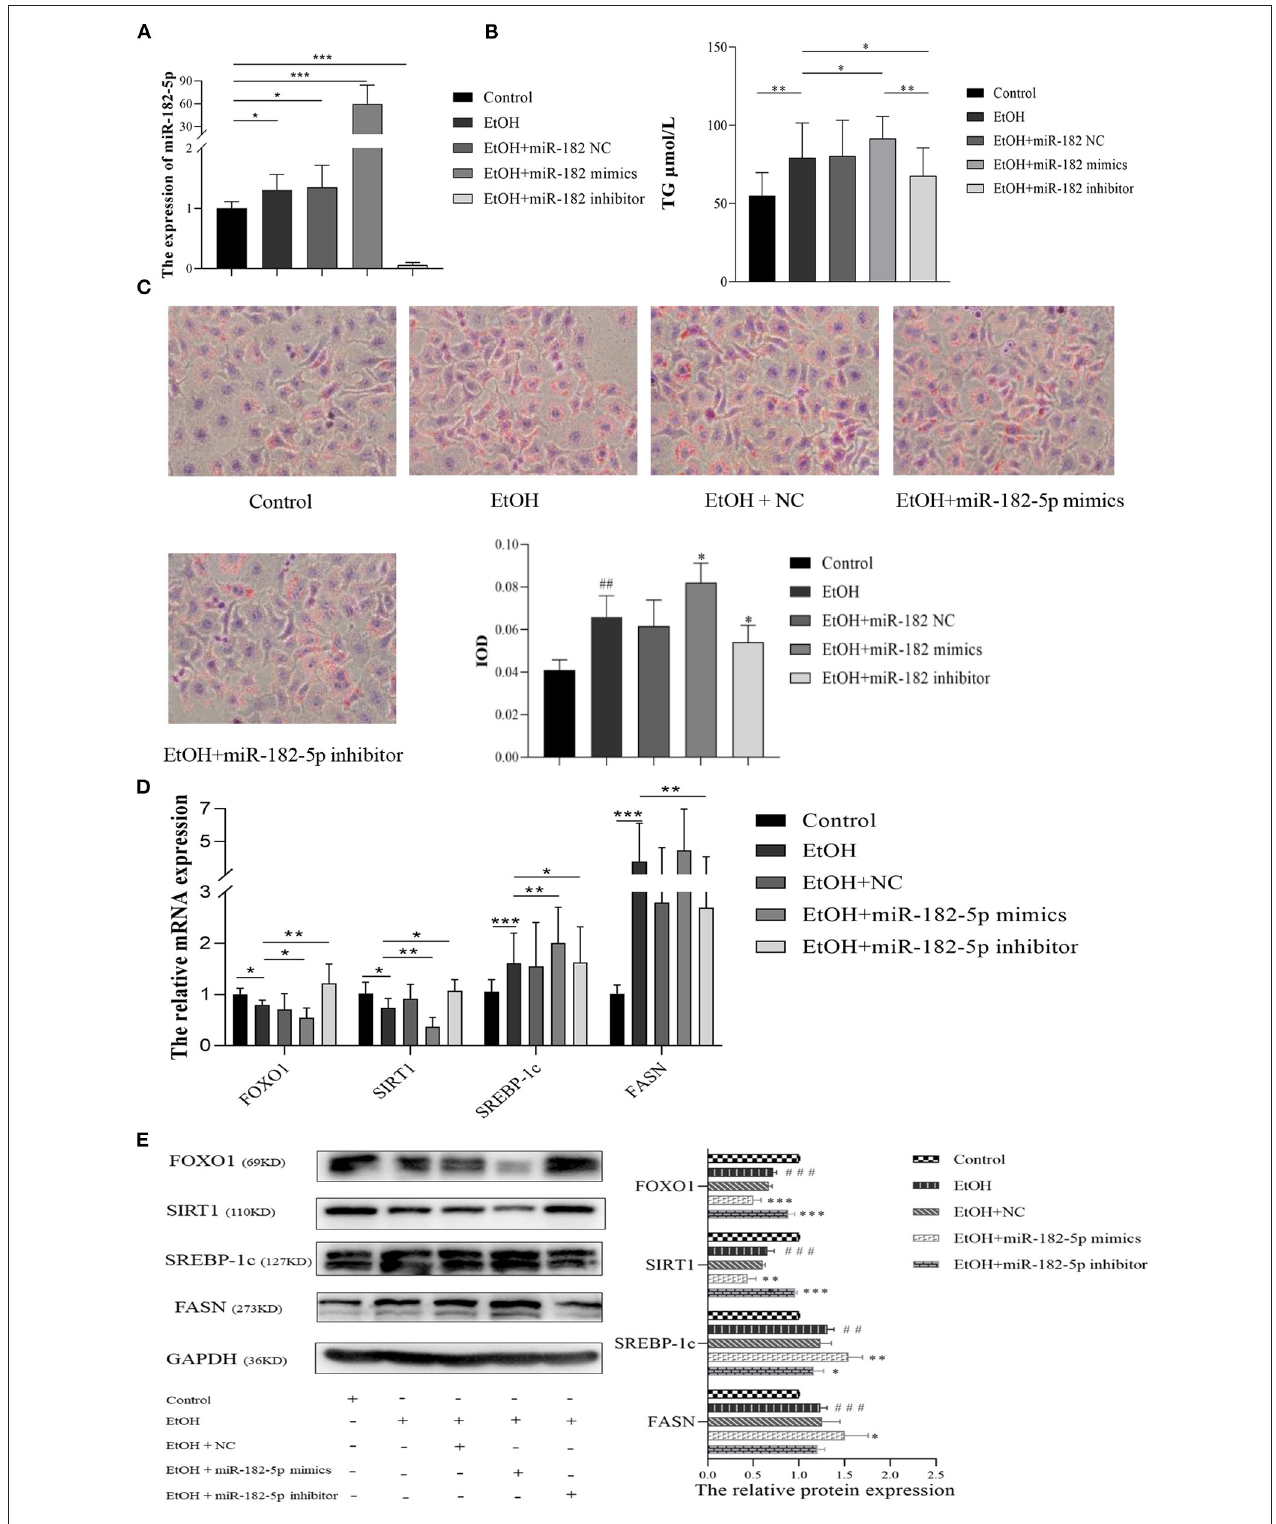
FIGURE 8 | The molecular mechanism of miR-182-5p in ALD lipid accumulation. (A) Verification of miR-182-5p expression, (B) TG levels of ALD cells with miR-182-5p mimics, NC, and inhibitor transfection, (C) Oil Red O staining and IOD analysis, (D) mRNA expression levels of FOXO1 downstream genes, (E) western analysis of FOXO1, SIRT1, SREBP-1, and FASN protein expression after transfection. TG, triglycerides; NC, negative control; IOD, integrated optical density. ## p < 0.01, ### p < 0.001 vs. control group; * p < 0.05, ** p < 0.01, *** p < 0.001 vs. EtOH group.